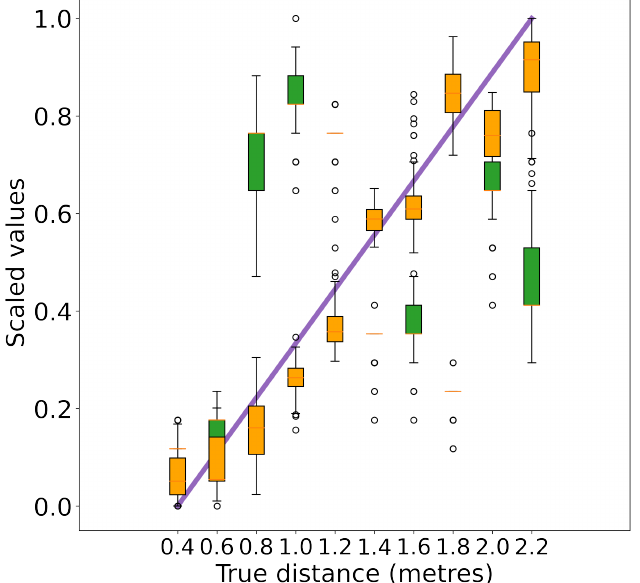
Figure 12. The comparison of the WiFi RSS and RTT measurements as a function of the true distance in a NLOS scenario. The WiFi signal was blocked by a thick wall. The RSS (as shown in green color) and RTT (as shown in orange color) values were scaled between 0 and 1. We observed that under NLOS conditions, RSS and RTT measures had similar